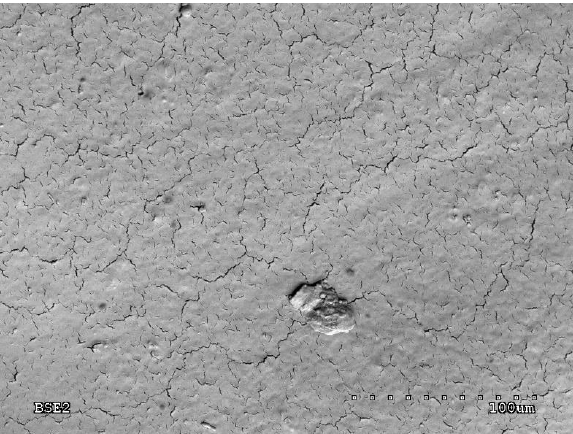
Figure 7. SEM image of the silver layer deposited on the Cordura unmodified substrate.